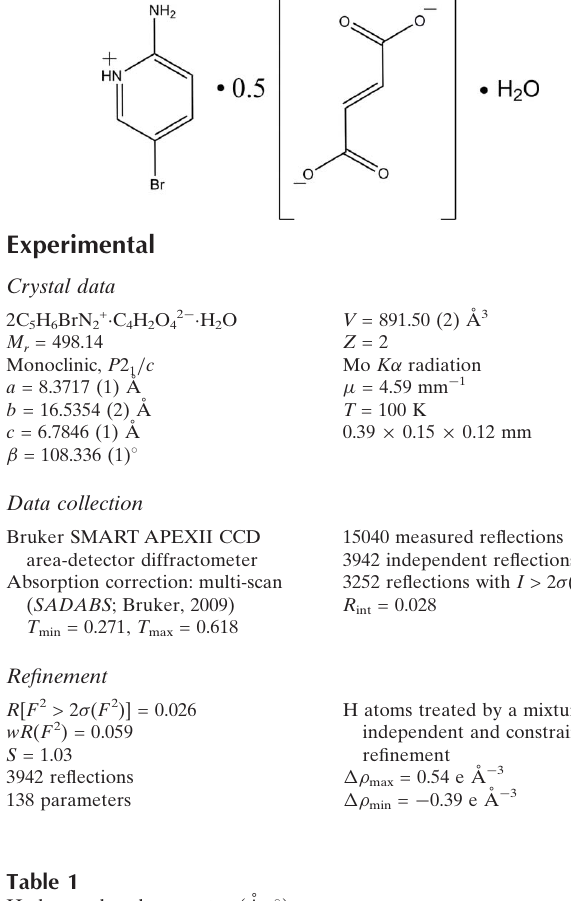
Hydrogen-bond geometry (A˚ , (cid:4)